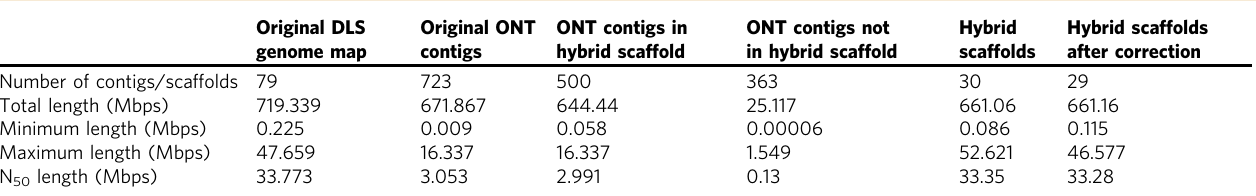
Merging of DLS optical maps with ONT contigs produced a hybrid assembly made of 29 scaffolds, totaling 661.16Mbps and with a scaffold N 50 value of